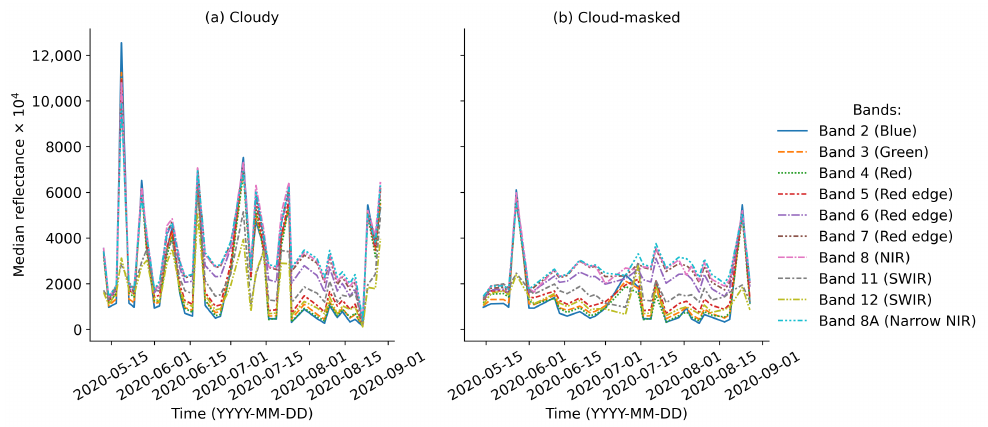
Figure 5. Median values of 10 Sentinel-2 bands from spring wheat fields of a farm calculated from ( a ) cloudy and ( b ) cloud-masked surface reflectance.